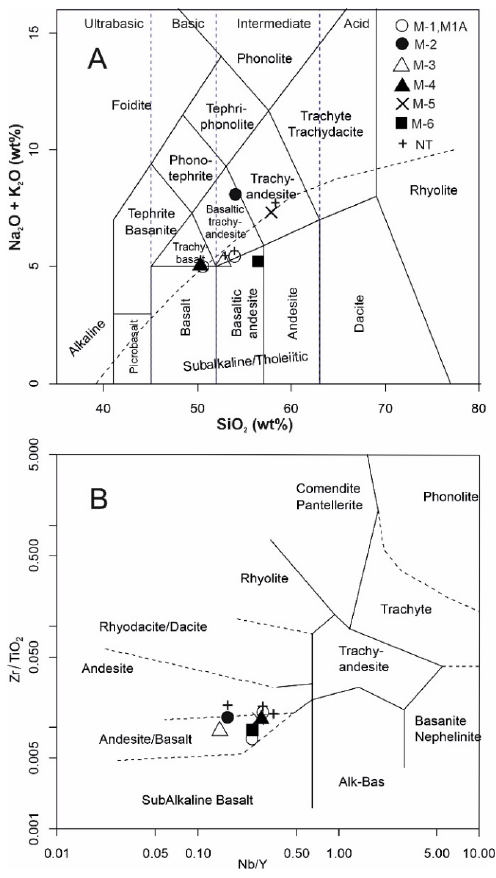
Figure 9. ( A ) TAS plot [60]; ( B ) Nb/Y vs. Zr/TiO 2 plot for studied basalts [56]. Sample M-1—M7 from Table 7, NT—analyses of paleobasalts from Vozár et al. [61].